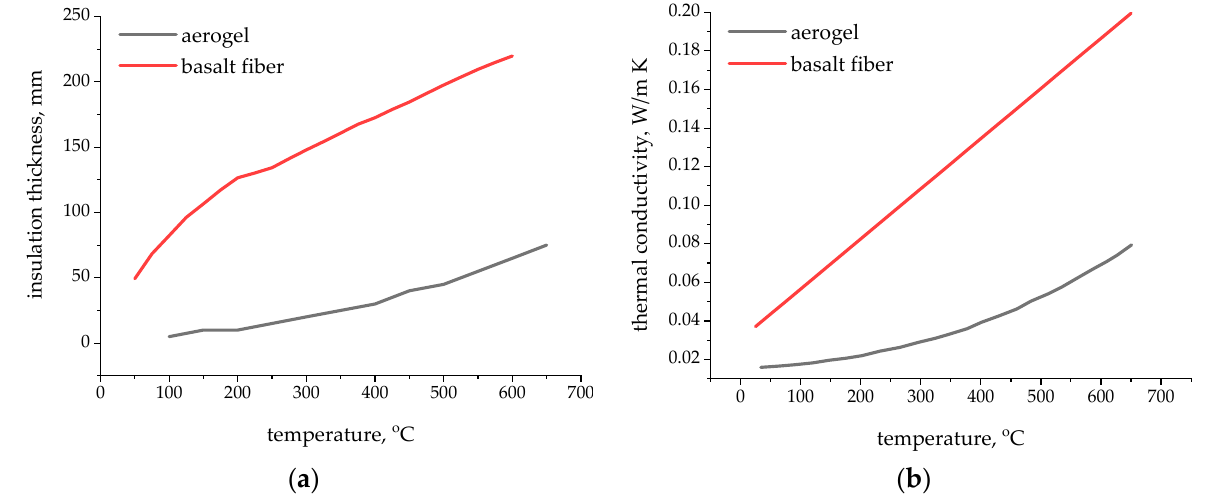
Figure 5. Parameters of insulating materials according to technical documentation: ( a ) minimum thickness; ( b ) thermal conductivity.